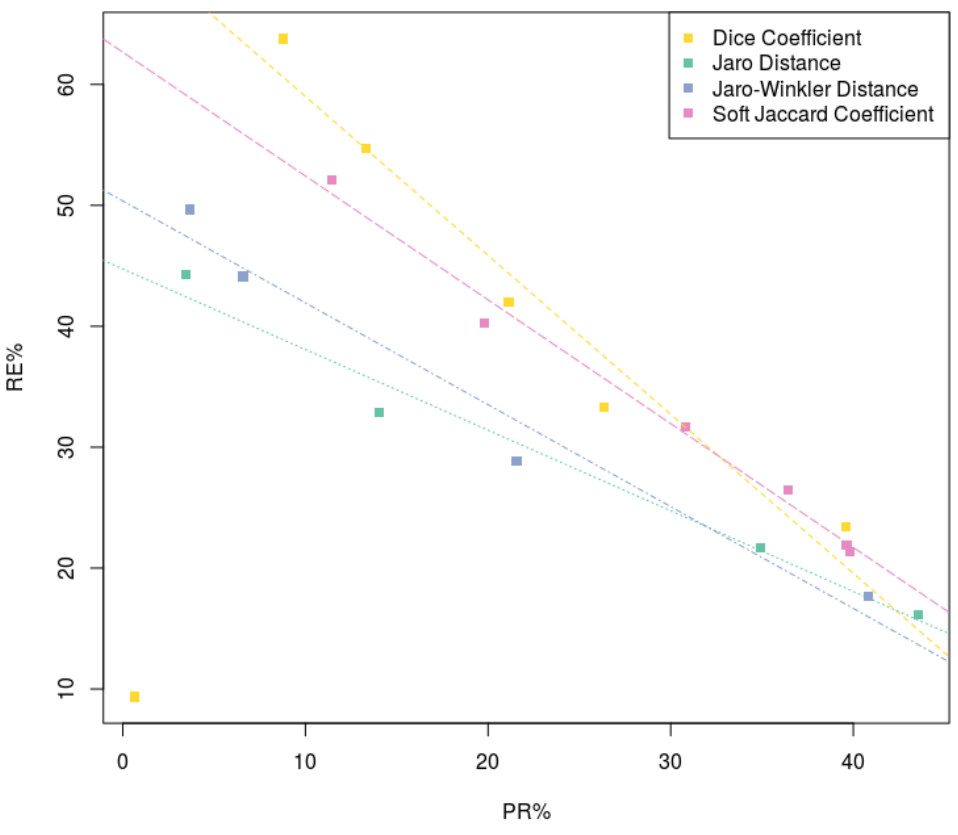
Figure 11. Recall over precision. In all configurations, increasing linking threshold drives to higher recall, reducing